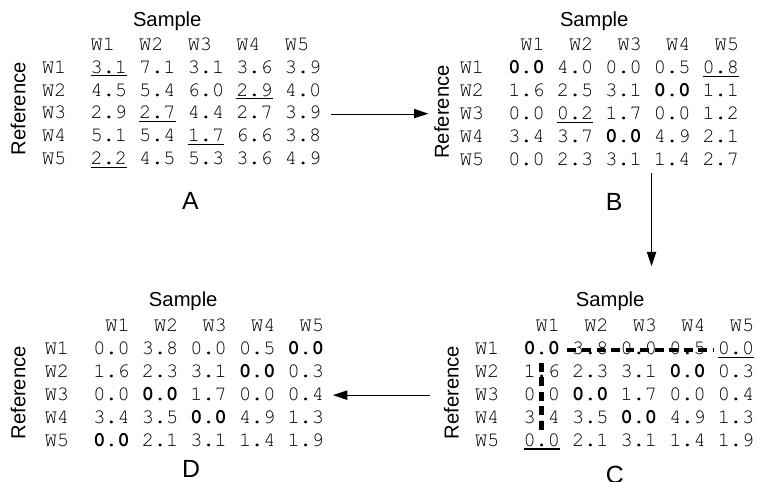
Figure 1. A sketch of some steps of the Hungarian algorithm. ( A ) The initial cost matrix (e.g., distances among five water molecules in the sample and reference configuration) is shown. The minima in each row are underlined and subtracted from the relative rows to yeld a new cost matrix. ( B ) The minimima different from zero in each column are underlined and subtracted from each column to yeld a new cost matrix. ( C ) In the new cost matrix, some “matching” zeroes (shown in bold) match one column and one row uniquely. Non-matching zeroes are underlined. Paths starting and ending on an underlined zero and alternating matching and non-matching zeroes, such as the one highlighted by the thick dashed line, are sought and new matching zeroes are chosen. If no such path exists, the algorithm performs subtractions and additions to the columns and the rows which do not alter the solution and create new paths [62]. This step is iterated until completion, to yeld a new matrix with a unique chosen zero on each row and each column. ( D ) The set of chosen zeroes in the matrix (one per row and column) is the sought assignment, i.e., in this example, W1 in the sample is assigned the label W5, W2 is assigned the label W3,